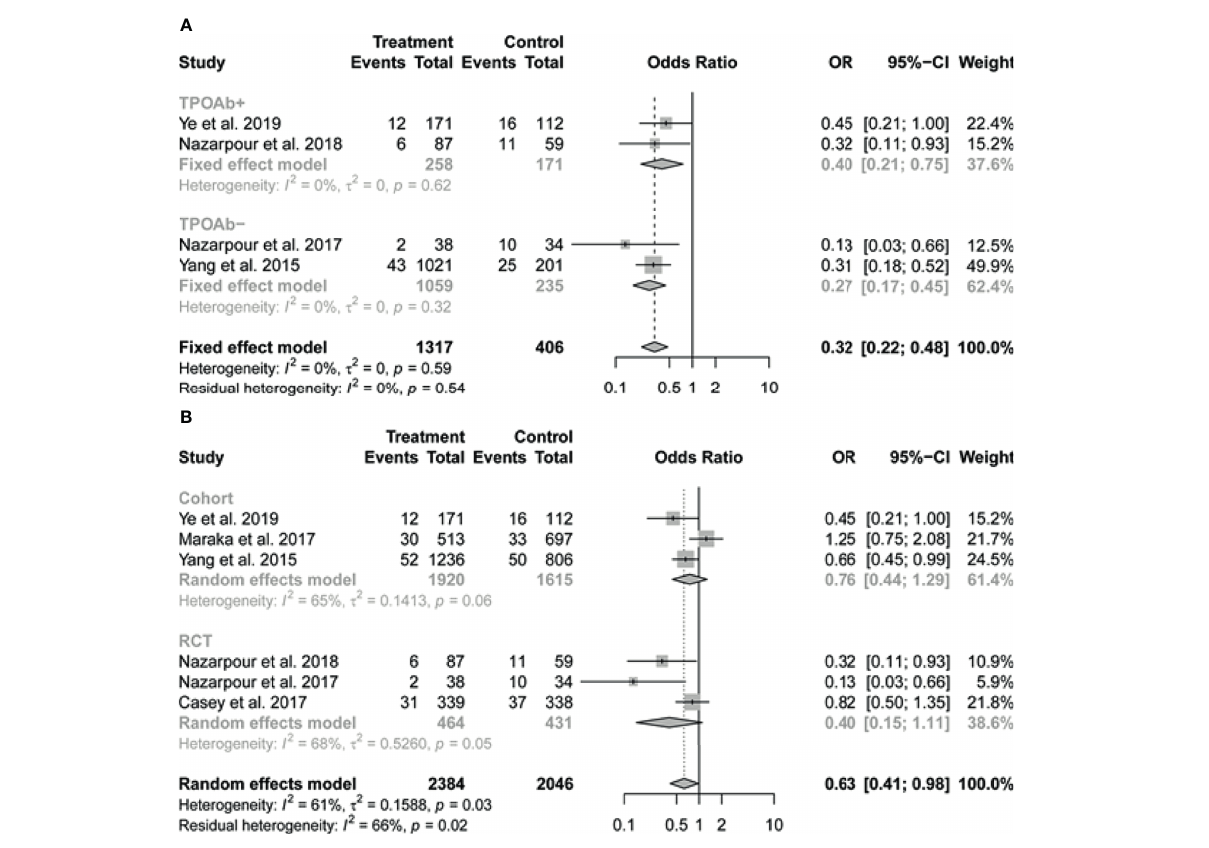
FIGURE 3 | Forest plots of pooled results on the association between levothyroxine treatment and the risk of preterm birth by subgroup analysis based on (A) TPOAb status (positive or negative) and (B) study design (RCT or cohort study). TPOAb, Thyroid peroxidase